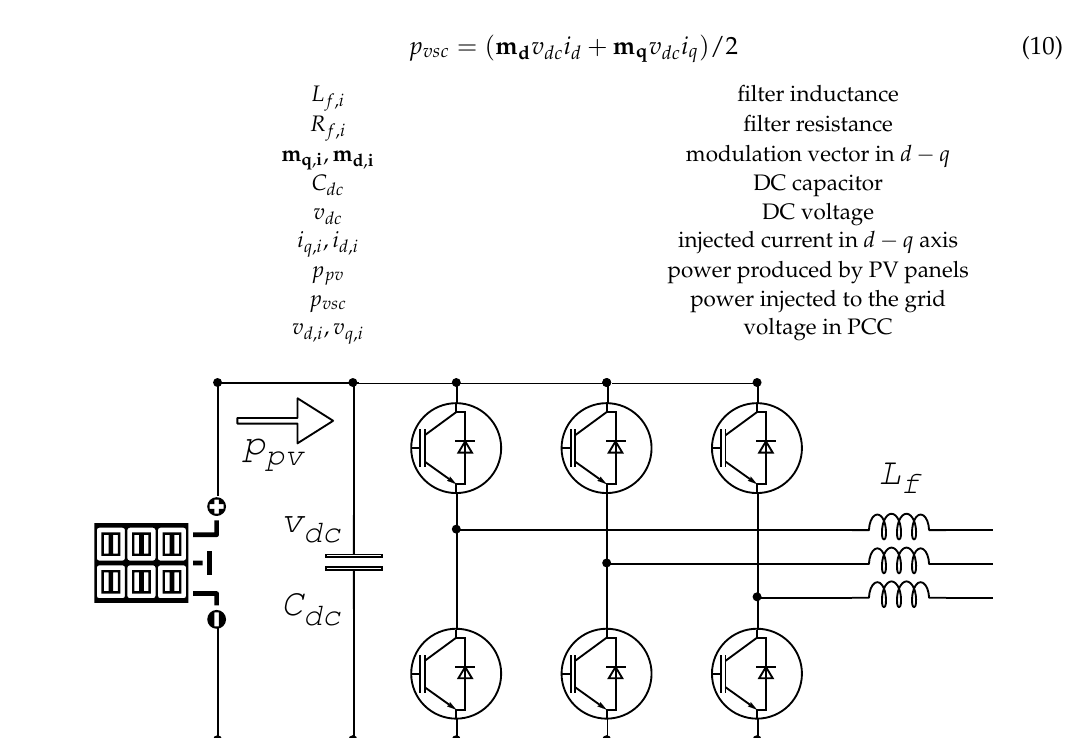
Figure 2. VSC schematic diagram.